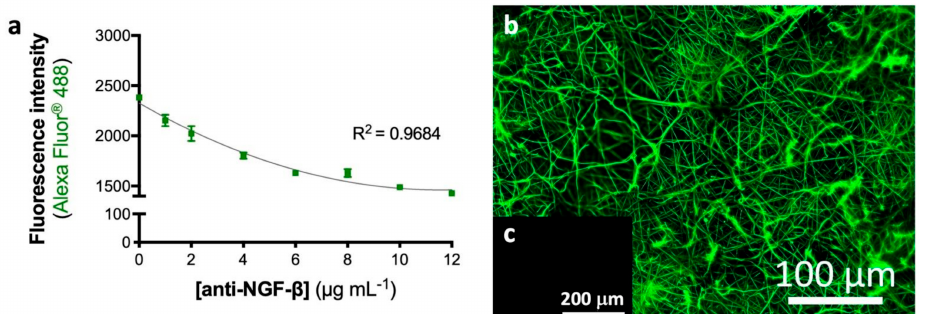
Figure 1. Activated and biofunctionalized eFM. Maximum immobilization capacity of anti-NGF- β antibody at the eFM surface ( a ). The one-way ANOVA with the Tukey’s HSD post hoc test were applied ( p < 0.01): a represents significant differences compared to concentration 0 µ g/mL; b represents significant differences compared to concentration 1 µ g/mL; c represents significant differences compared to concentration 2 µ g/mL; d represents significant differences compared to concentration 4 µ g/mL; e represents significant differences compared to concentration 6 µ g/mL and f represents significant differences compared to concentration 8 µ g/mL. Spatial distribution of 10 µ g/mL anti-NGF immobilized at the eFM surface ( b ). The negative control sample was not incubated with the primary antibody ( c